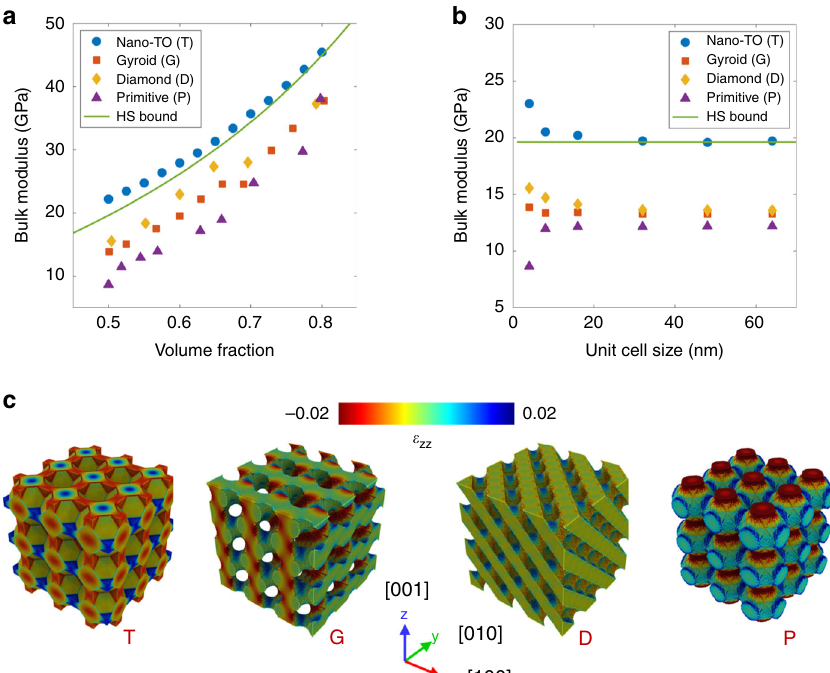
Fig. 3 Performance of Nano-TO design and TPMS structures. a The bulk moduli of the Nano-TO design (blue circles), gyroid structure (red squares), diamond structure (yellow diamonds), and primitive structure (purple triangles) with varying volume fractions in comparison with the HS upper bound (green line). The cell size in the comparison is 4 nm. b The bulk moduli of the Nano-TO design (blue circles), gyroid structure (red squares), diamond structure (yellow diamonds), and primitive structure (purple triangles) with varying cell sizes from 4 to 64 nm in comparison with the HS upper bound (green line). The volume fraction in the comparison is 50%. c Atomic strain ( ε zz ) distributions of those structures subjected to a constant hydrostatic strain of − 10 − 2 . The cell size of those structures is 16 nm and the volume fraction is 50%. The average atomic strains for the Nano-TO design (T), gyroid (G), diamond (D), and primitive (P) are − 0.0048, − 0.0033, − 0.0035, and − 0.0029,